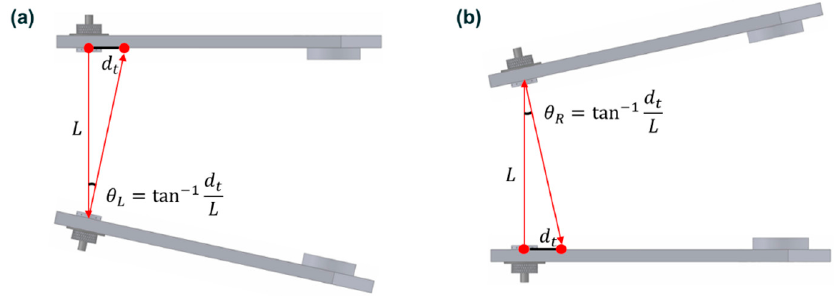
Figure 7. Toe angle measurement. ( a ) Left toe. ( b ) Right toe.